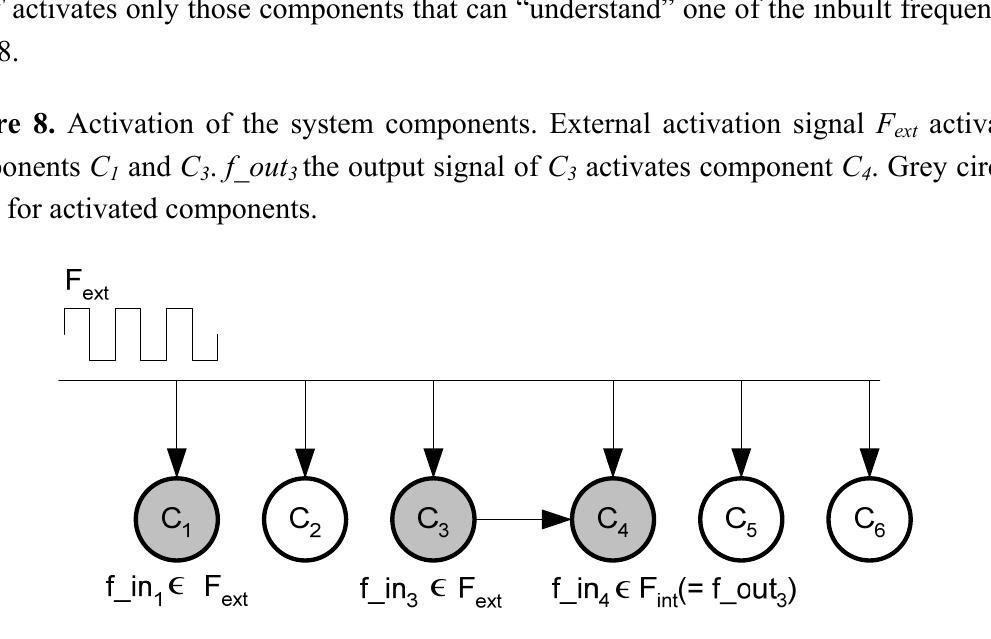
activates ext . Grey circles 4